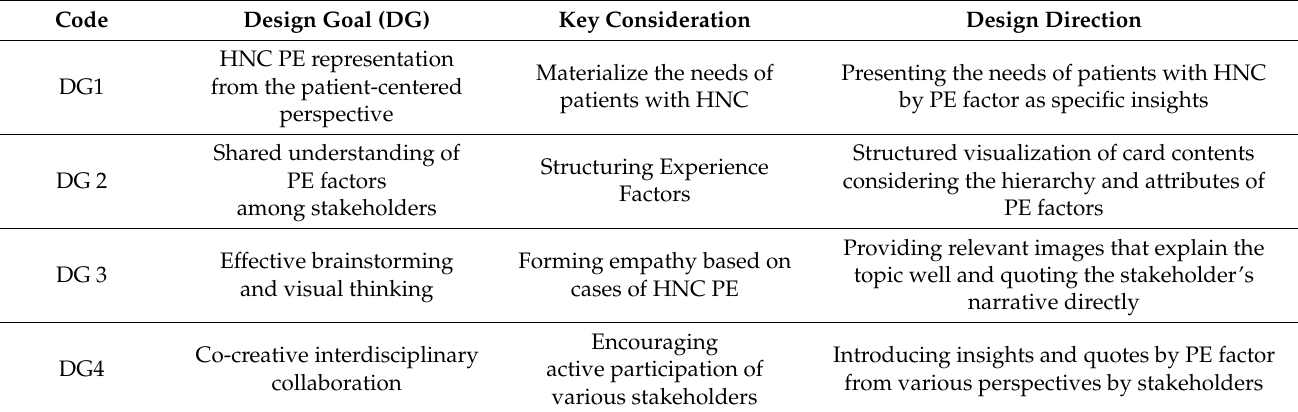
Table 1. Key considerations and design direction for ‘ Pat Exp Insight Cards for patients with